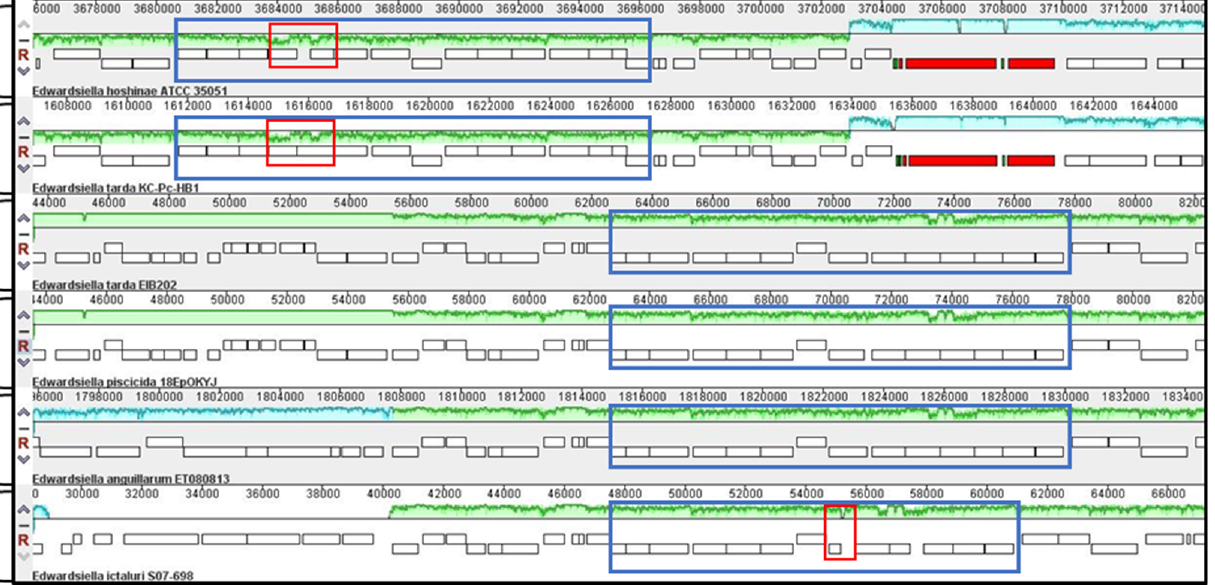
Figure 1. Comparative genomic analysis using progressive Mauve to identify the waa cluster on the chromosomes of E. hoshinae ATCC35051 (track 1), E. tarda KC ‐ Pc ‐ HB1 (track 2), E. tarda EIB202 (track 3), E. piscicida 18EpOKYJ (track 4), E. anguillarum ET080813 (track 5) and E. ictaluri S07 ‐ 698 (track 6). Matching colors indicate homologous segments that are connected across genomes. Chromosomal regions inside blue squares contain waa clusters, and red squares show differences in comparison to E. tarda EIB202.